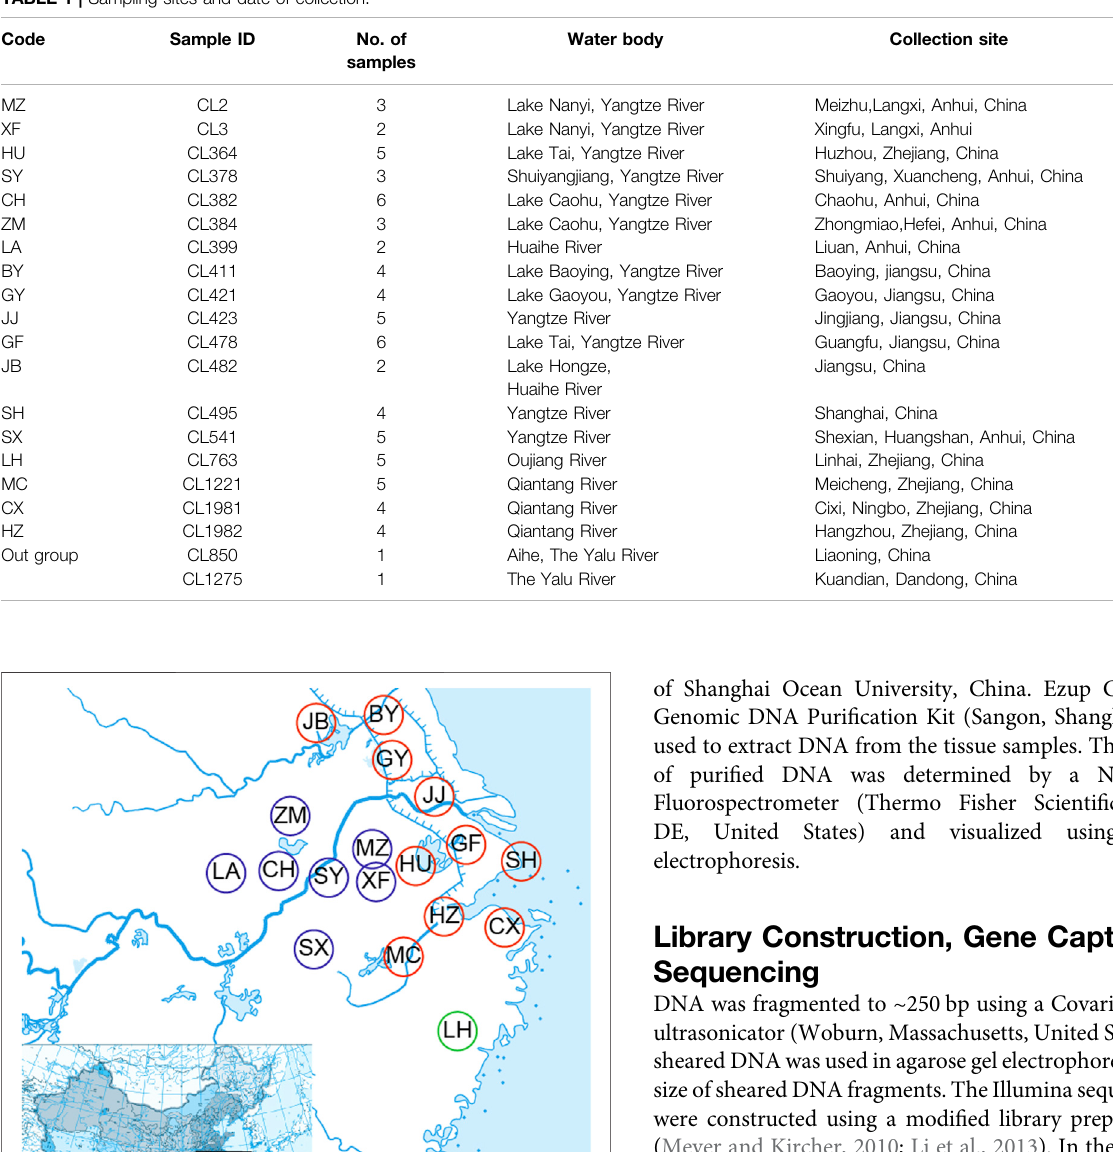
TABLE 1 | Sampling sites and date of collection.